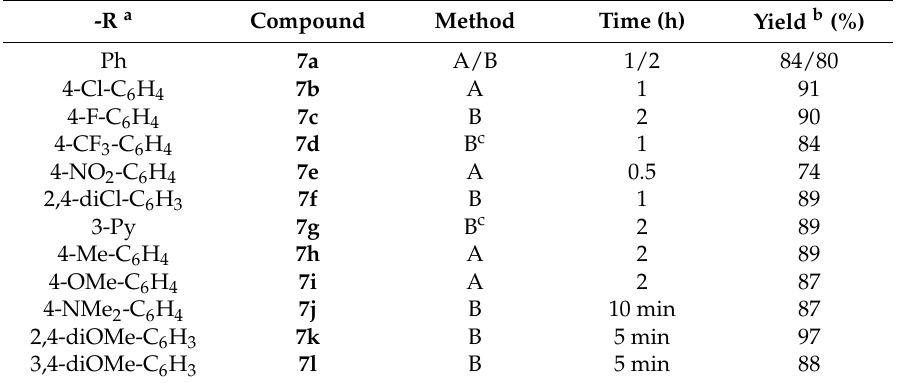
Table 1. Chemical structures and yields obtained for the synthesis of series 7a – l . -R a Compound Method Time